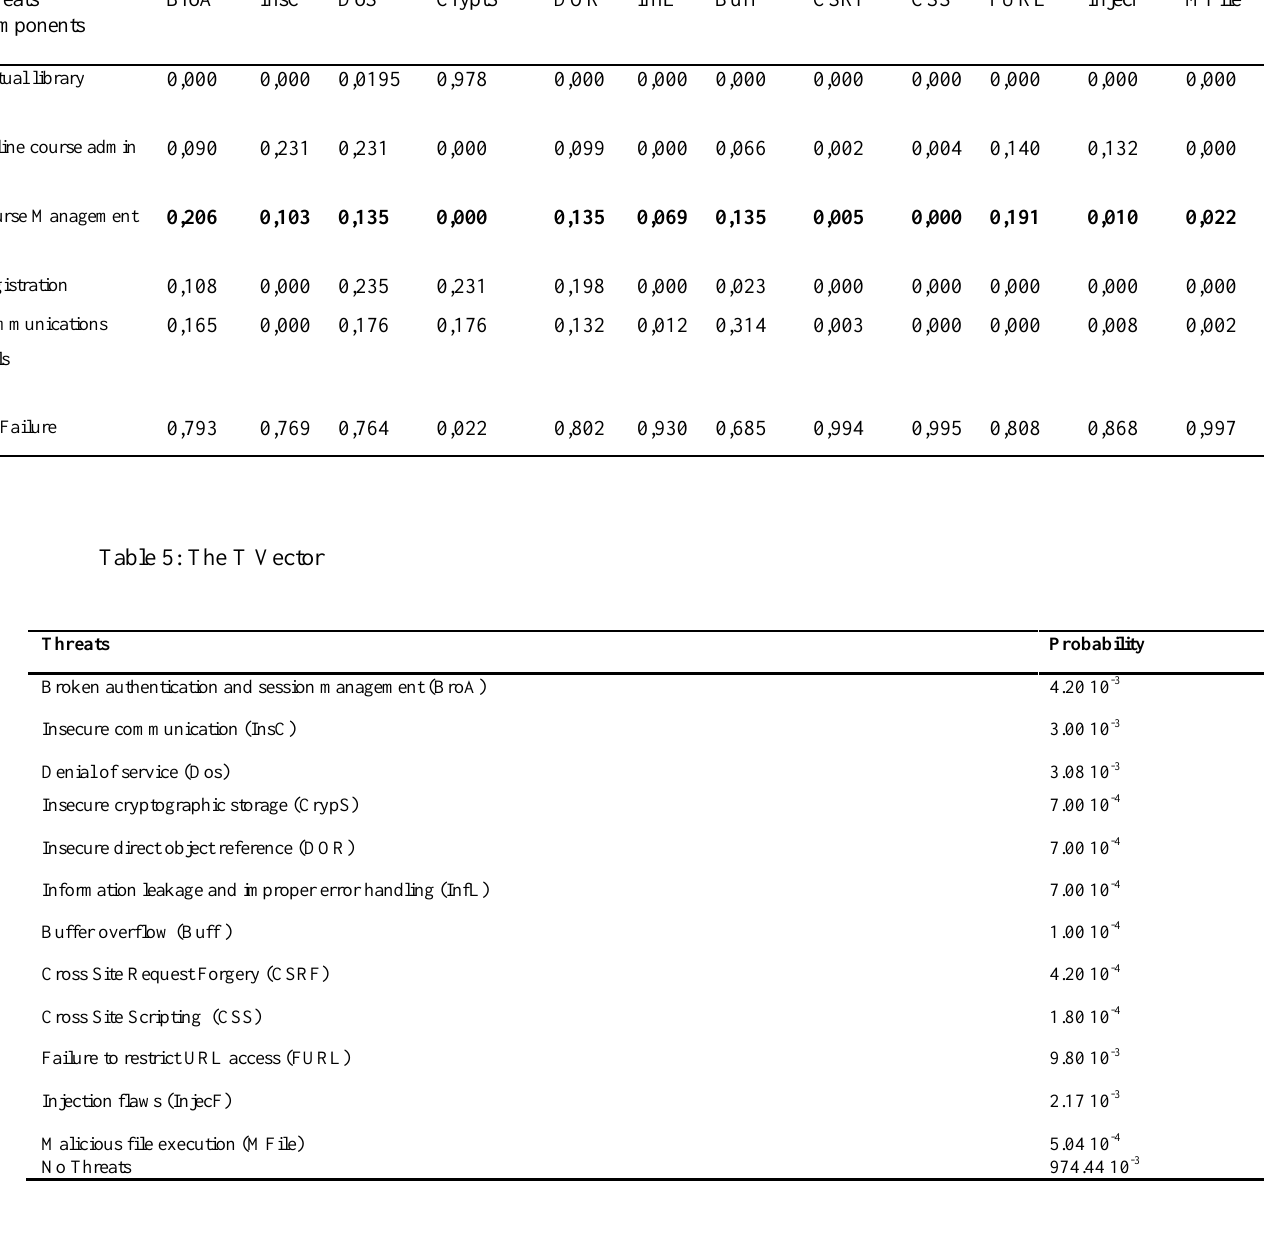
Threats Components Threats